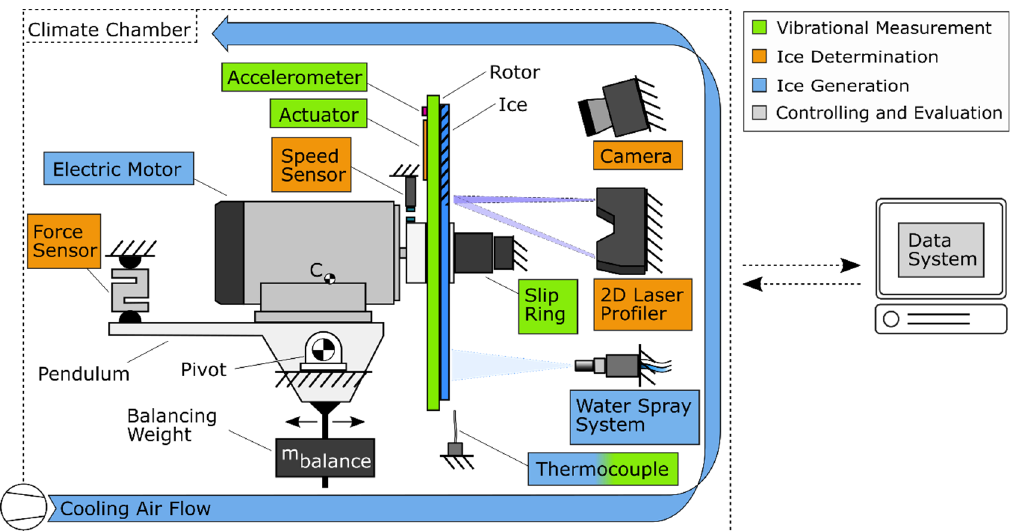
Figure 4. Illustration of the test bench with its components that is used to create icing on a GFRP rotor.